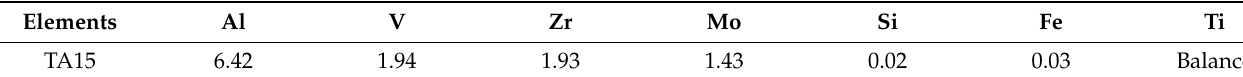
Table 1. Chemical composition (Wt. %) of the TA15 titanium alloy powder.